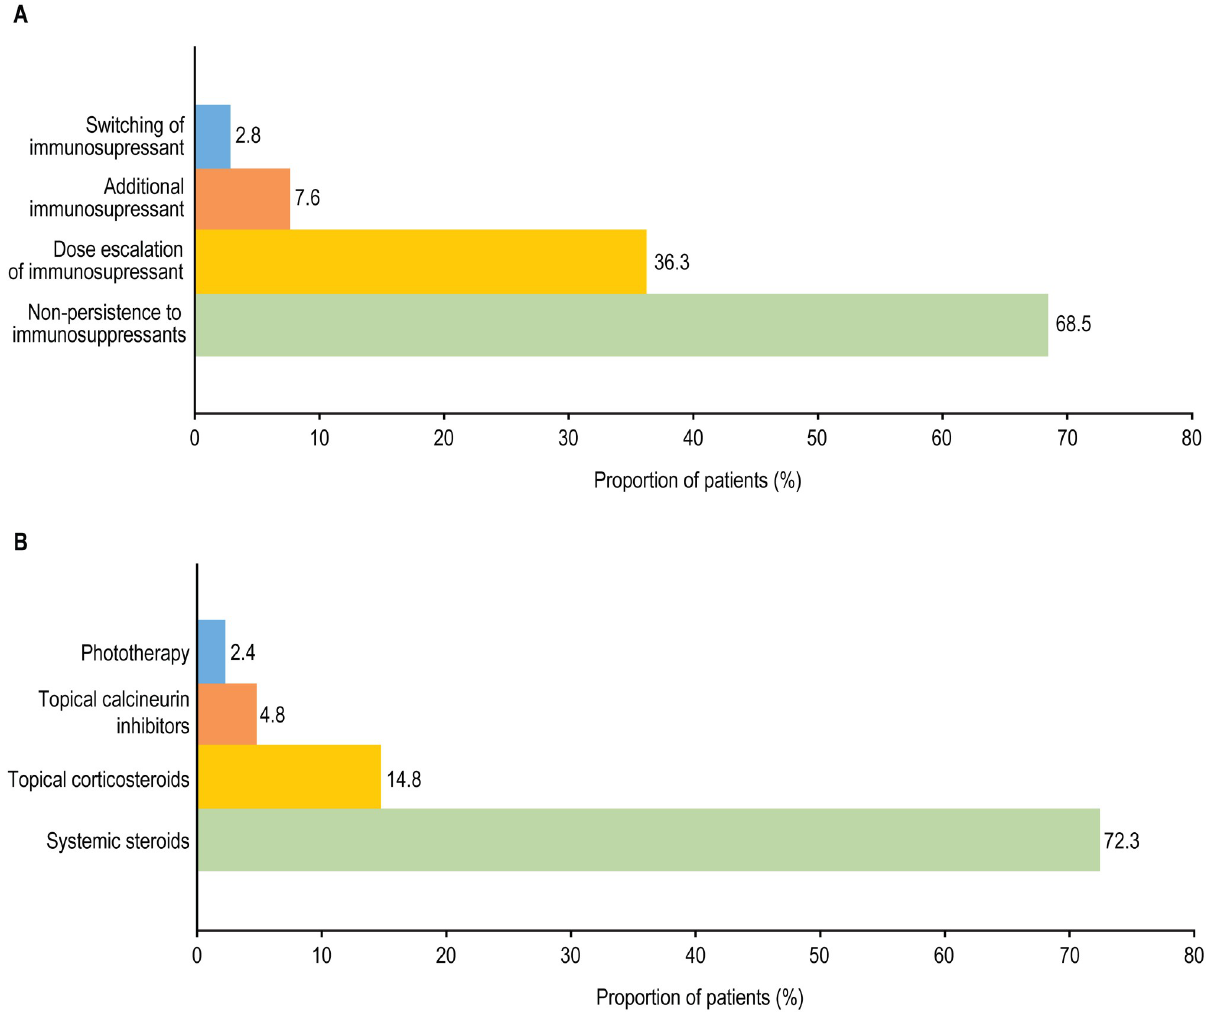
Fig 2. Systemic immunosuppressant treatment changes (n = 4204) (A) during 12-month follow-up period (B) and use of alternative